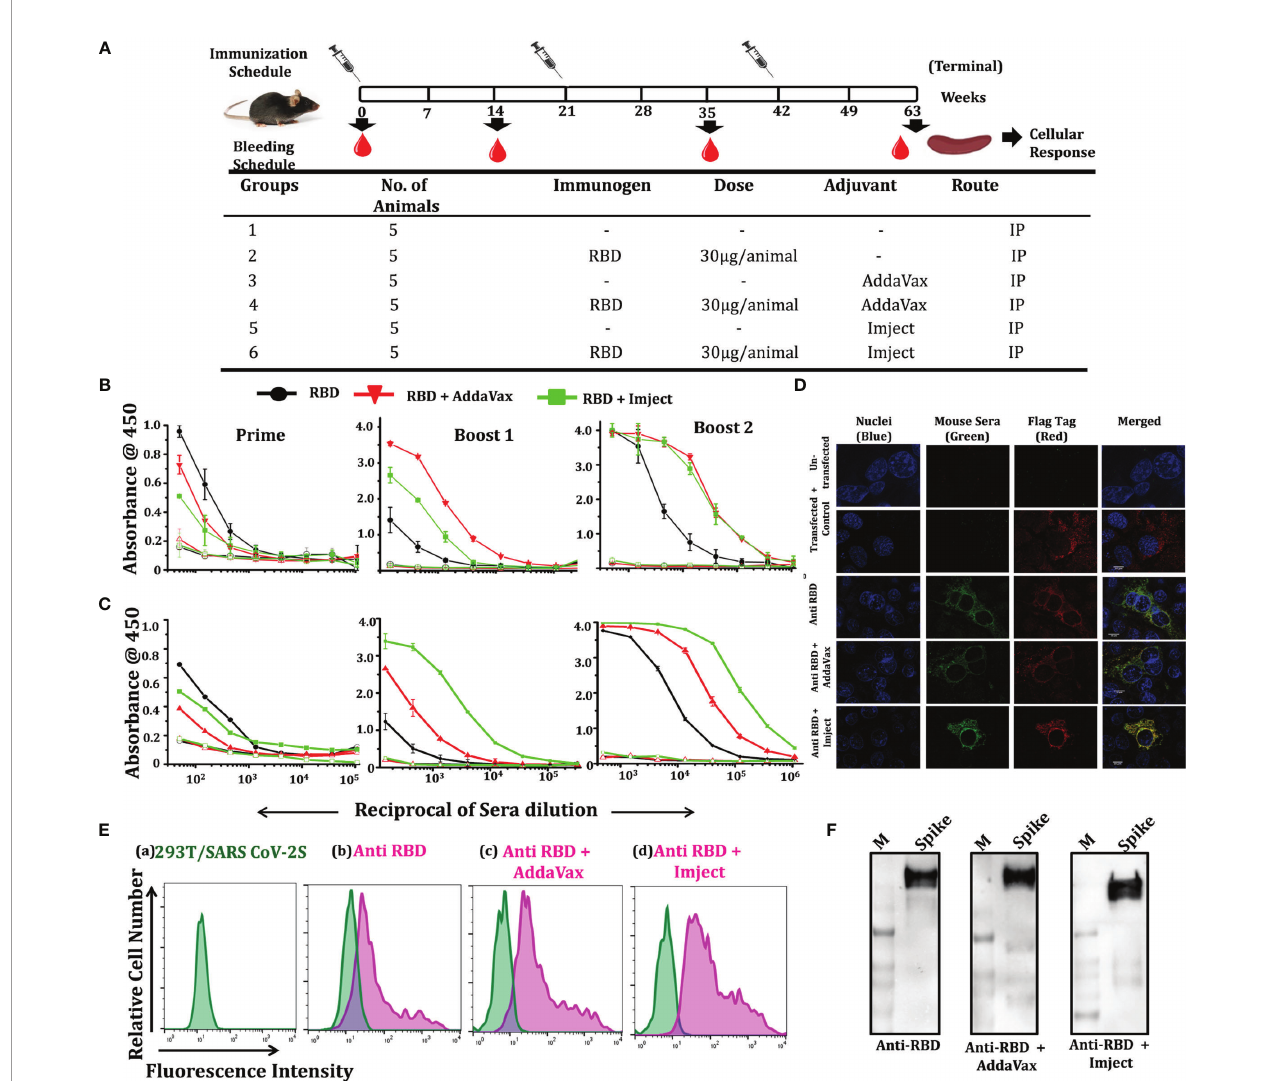
FIGURE 4 | Immunization strategy, RBD speci fi c antibody titers, and cell surface interaction with spike. (A) Schematic representation of the immunization schedule of mice, showing immunization and bleeding time point, different groups, number of animal/group, immunogen, immunogen concentration, used adjuvants, and route of administration. Humoral response studies at each bleeding time point and cellular response studied 14 days post fi nal immunization. (B) Dose-dependent binding response of RBD-immunized sera in different formulation towards RBD and pre-fusion spike trimer (S2P) (expression and puri fi cation spike trimers elaborated in Supplementary Information ). (C) Prime; starting dilution used was 1:50, followed by 3-fold serial dilution of sera, boost 1; starting dilution used was 1:150, shows no signi fi cant increase in antibody titer in RBD alone group post fi rst boost, with increase in binding antibody response in the other groups, boost 2; increased of antibody titers in all the RBD immunized groups with the RBD + AddaVax and RBD + Imject groups showing high end point titers (starting dilution 1:500). The overall response toward the spike trimer was similar to the RBD with a higher end point titer as compared to RBD. (D) Immuno fl uorescence detection of SARS-CoV-2 spike (SARS-CoV-2 S with 3X Flag-tag) by RBD immunized sera: immunized serum IgG from different immunized groups was used as a primary antibody and probed with secondary antibody Alexa-Fluor 488-labeled anti-mouse antibody (green) (1:100). Anti-Flag antibody (red) and nuclei were stained with 4 ’ ,6-diamidino-2-phenylindole (DAPI, blue). Scale bar: 10 m m and magni fi cation 60x. (E) Representative overlaid histograms of SARS-CoV-2 S with 3X Flag-tag transfected 293T cells, a) SARS- CoV-2 S transfected 293T cells, b) stained with anti-RBD IgG, c) stained with anti-RBD+AddaVax IgG, and d) stained with anti-RBD+Imject IgG as the primary antibody. Anti-RBD antibody binds strongly to the SARS-CoV-2 spike expressed at the cell surface, (F) western blots using pooled sera from each RBD formulation immunized group was used as a primary antibody, which ef fi ciently recognizes a spike protein band of ∼ 180